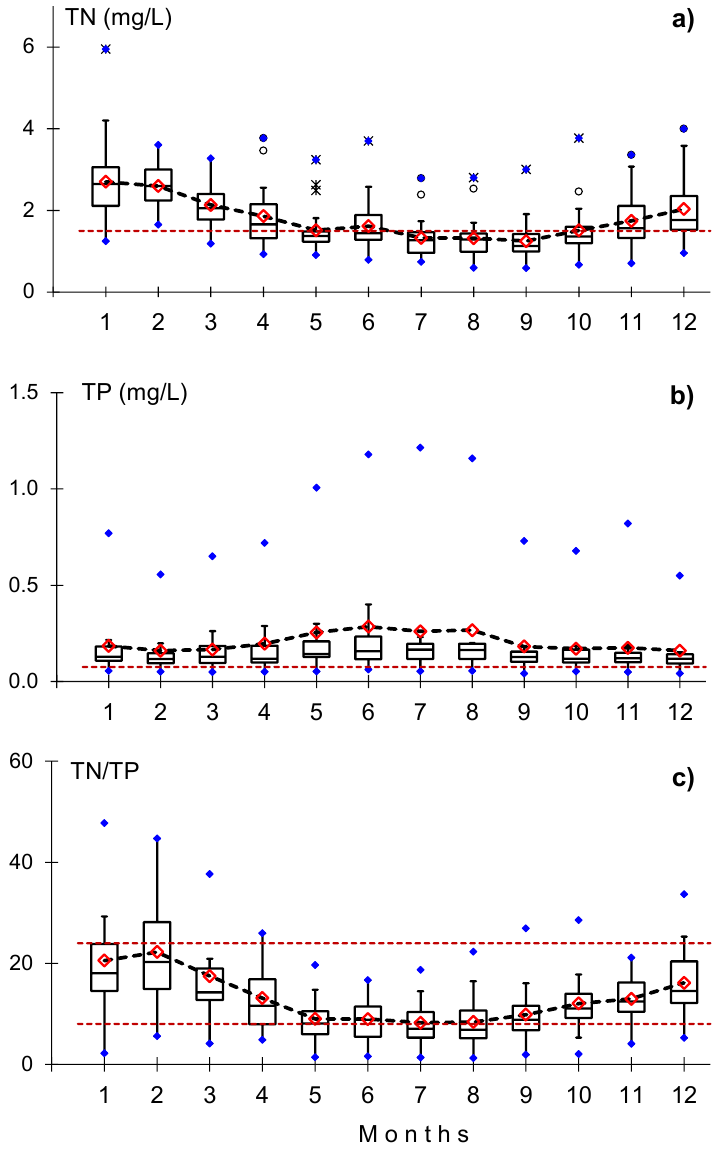
Figure 4. Temporal distribution of: ( a ) TN concentrations, ( b ) TP concentrations and ( c ) TN:TP mass ratios in examined water samples. Red lines indicate eutrophic status limits ( a ) TN > 1.5 mg/L, ( b ) TP > 0.075 mg/L and ( c ) TN/TP mass ratio of potentially N-limited (TN/TP<8) or P-limited (TN/TP >24).